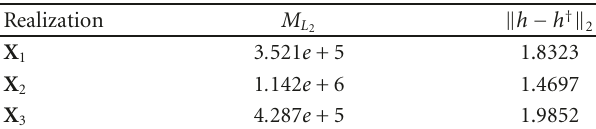
Table 1: M L -sensitivity measure and transfer function error for 2 di ff erent